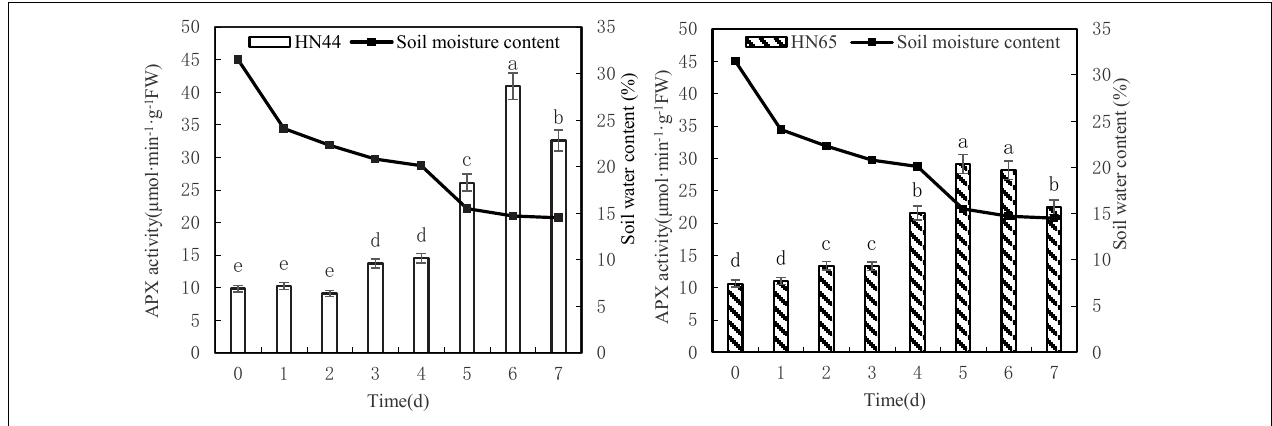
FIGURE 7 | Effect on APX activities under different soil water contents. Indicates that the values marked with different letters are significantly different, and those marked with the same letter are considered to be statistically insignificant. TABLE 8 | Effect of drought on the relative growth rate of APX activity (%). Varieties 0